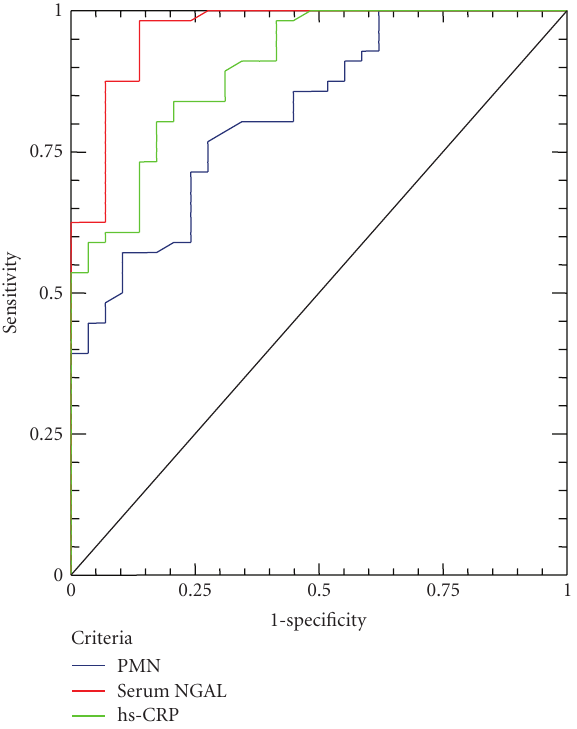
Figure 6: ROC curve analysis for CRP (green line), serum-NGAL (red line), and PMN (blue line) for the discrimination of ACS patients from patients with